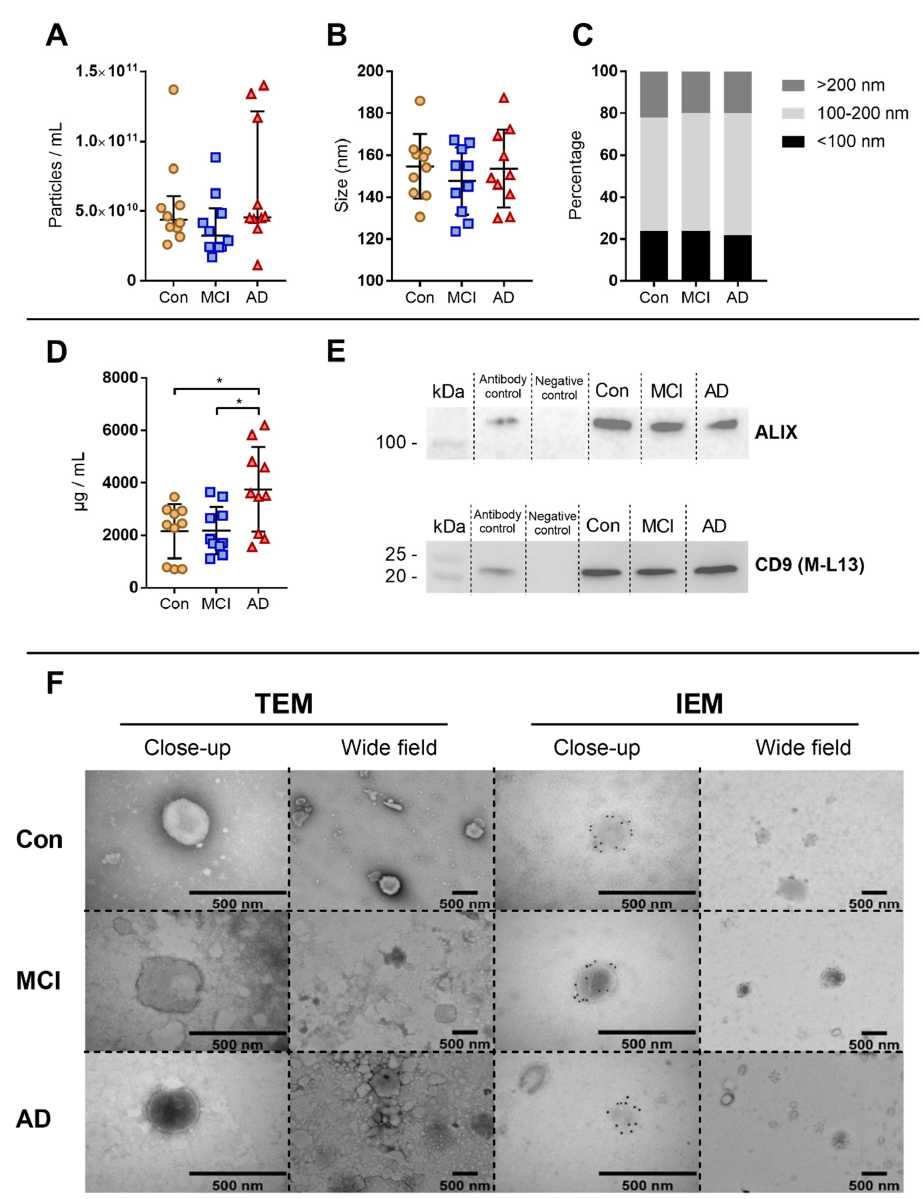
Figure 1. Extracellular vesicles characterization. Nanoparticle tracking analysis (NTA) was performed for controls and patient groups to determine ( A ) particle concentration and ( B ) mean particle size. ( C ) Size distributions of the measured particles were divided into three subgroups consisting of particles <100 nm, 100–200 nm, and >200 nm. ( D ) Protein concentrations of extracellular vesicles (EV) pellets measured by BCA. Alzheimer’s dementia (AD) patients had a significantly higher mean protein concentration compared to the Mild Cognitive Impairment (MCI) and controls groups. Scatter plots depict the median with interquartile range (IQR) and mean ± SD, respectively. ( E ) EV pellets were pooled within their respective groups and an equal volume of pellets were analysed by western blotting for the EV markers CD9 and ALIX. A positive signal for all markers were found in all three groups. ( F ) Transmission Electron Microscopy (TEM) images of negative stains of pooled EV pellets, as well as immunolabelling (IEM) images of CD9 positive particles identified in EV pellets. The immunoreactivity in the IEM images is mainly confined to the membrane of the EVs. Both close-up and wide field images are shown. The scale bar is 500 nm. * indicates p <